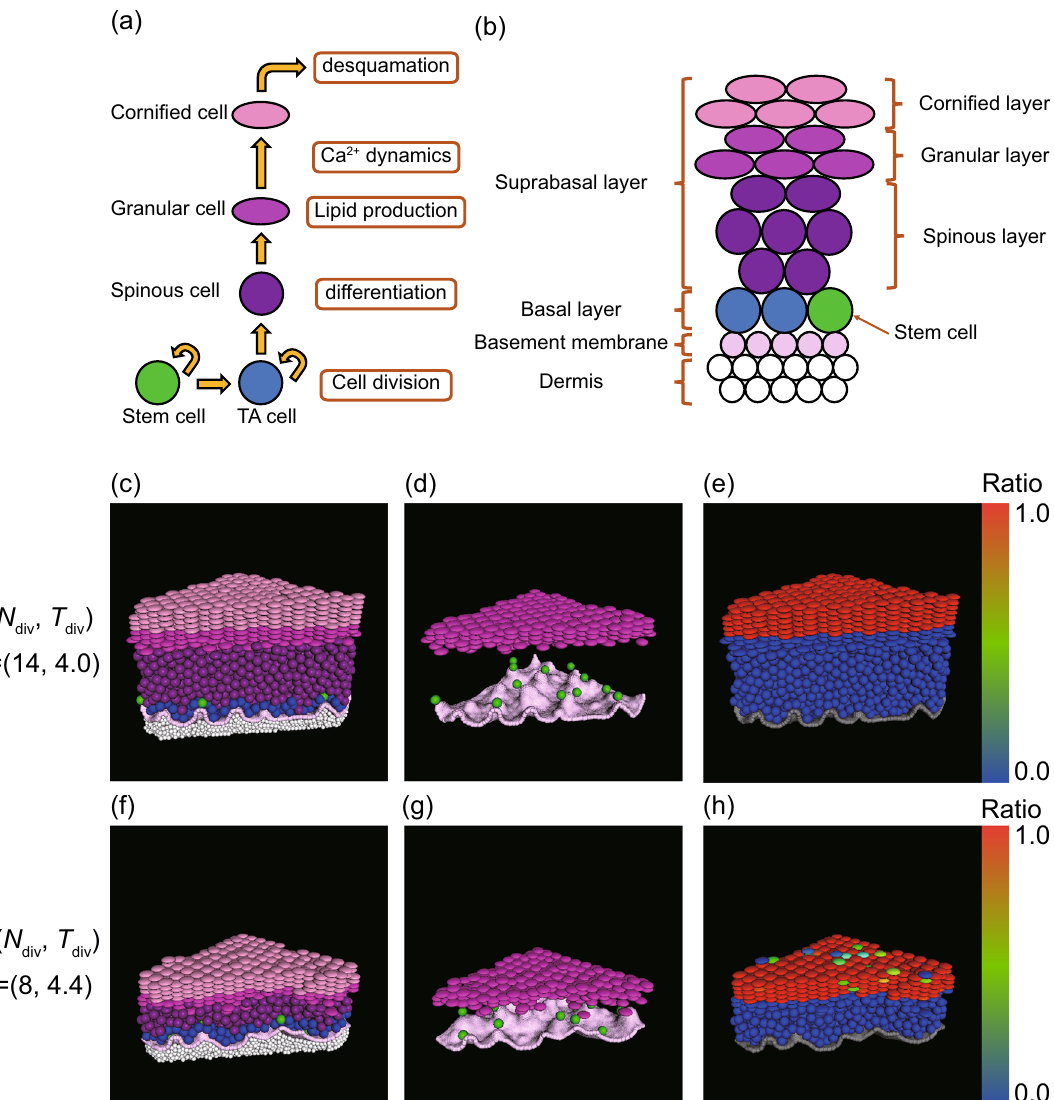
Figure 1. Simulation for the development of the epidermis. ( a ) Modeling of cell dynamics. ( b ) Schematic representation of the dermis, the basement membrane, and different layers of the epidermis. ( c )–( h ) Simulation snapshots for two different sets of N div (maximum number of cell divisions) and T div (cell division period): ( c – e ) ( N div , T div ) = ( 14, 4.0 ) , ( f – h ) ( N div , T div ) = ( 8.0, 4.4 ) . ( c ), ( f ) Overview of the epidermal model, colored in the same way as ( b ): the dermis (white), the basement membrane (light pink), stem cells (green), TA cells (blue), spinous cells (purple), granular cells (dark magenta), cornified cells (dark pink). ( d ) and ( g ) are the same as ( c ) and ( f ), respectively, with only the basement membrane, stem cells, and granular cells are visualized. ( e ) and ( h ) are the same as ( c ) and ( f ), respectively, with cells colored according to the ratio of the lipid content to the maximum lipid